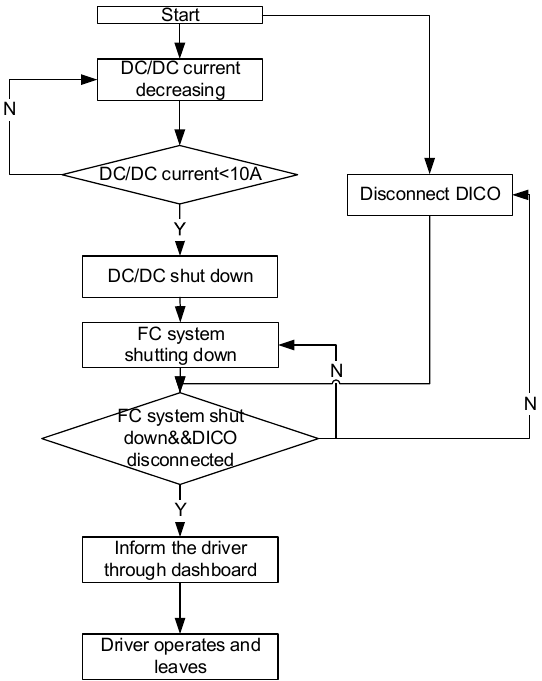
Figure 7. Flow chart of stop process.